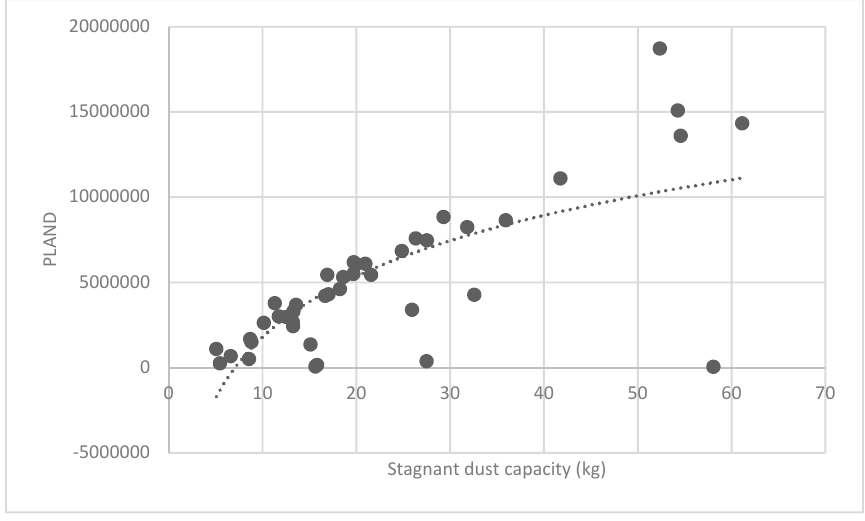
Figure 17. Association between forest land PLAND index and stagnant dust capacity.